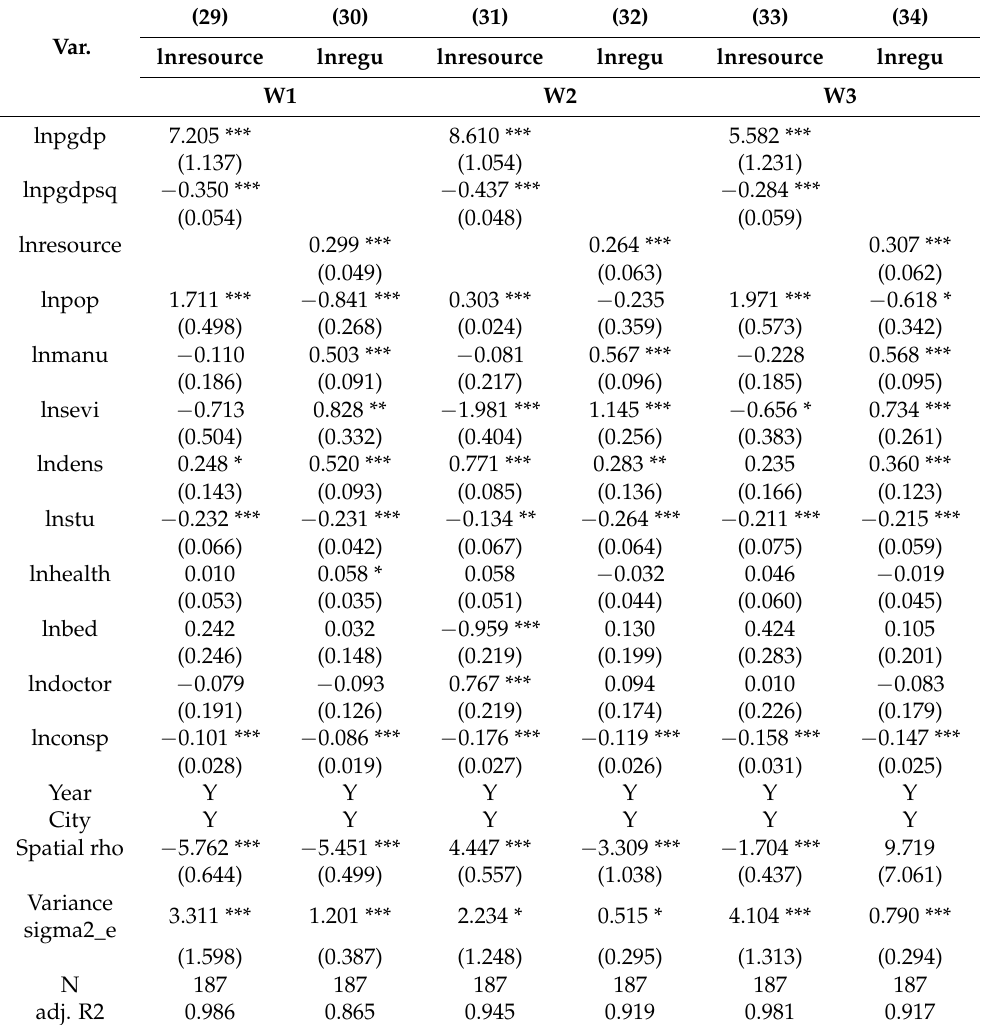
Table 6. The resource consumption effect